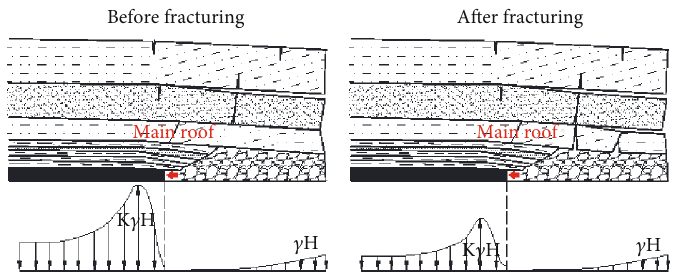
Figure 10: Reduction in advance abutment pressure after